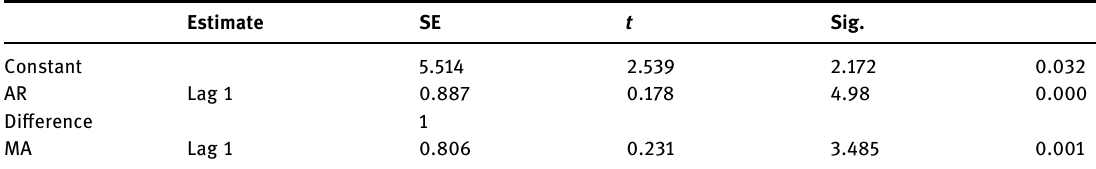
Table 2: Model parameters of ARIMA ( 1,1,1 )